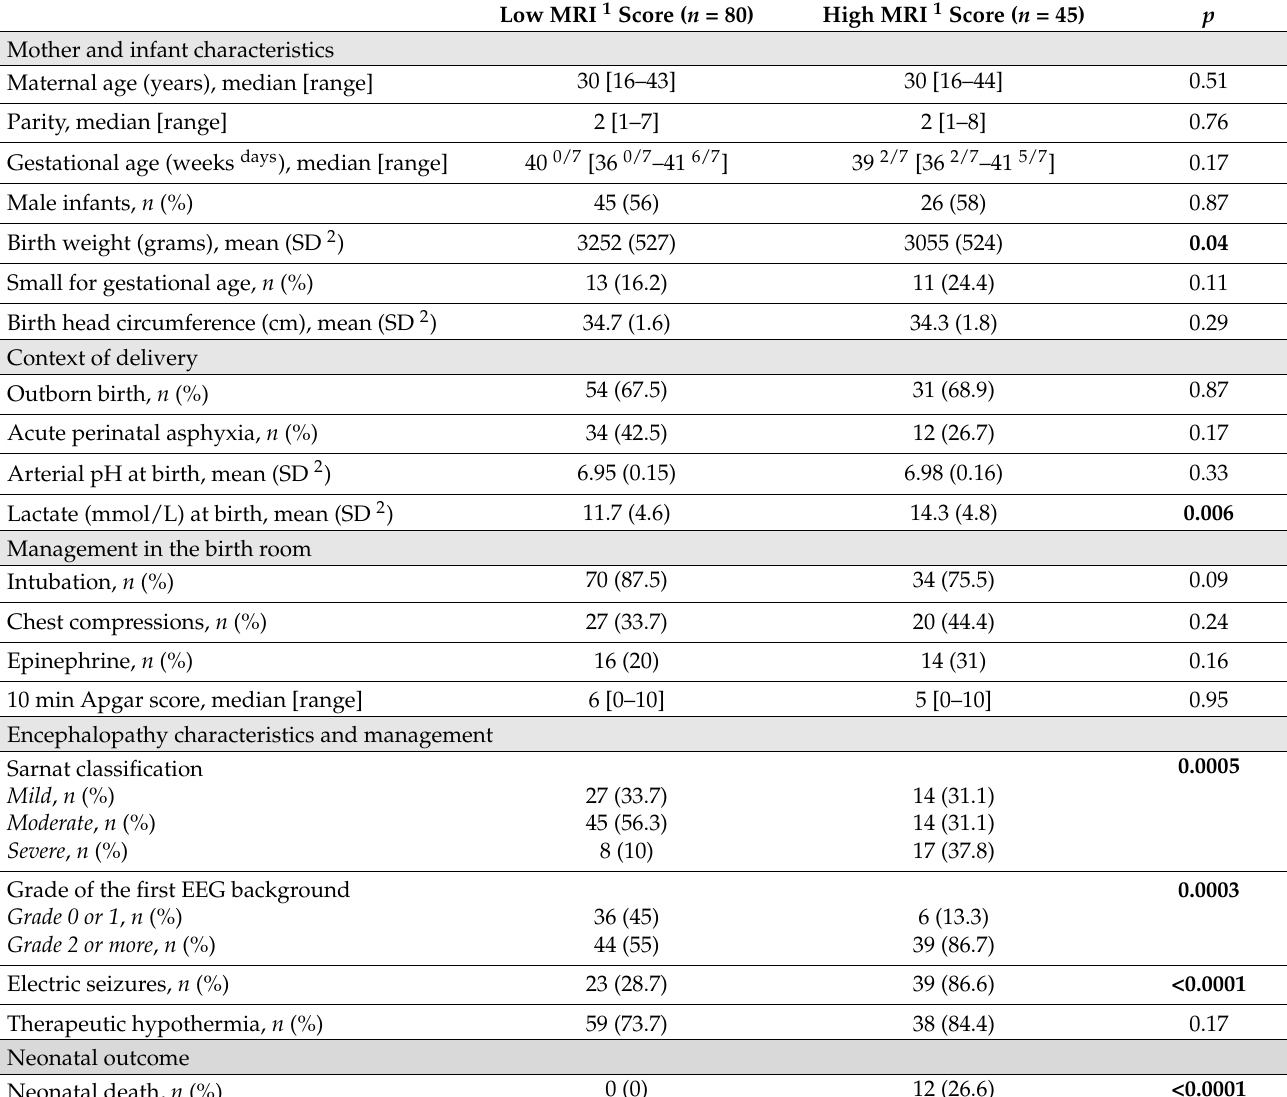
Table 2. Patient characteristics according to the MRI